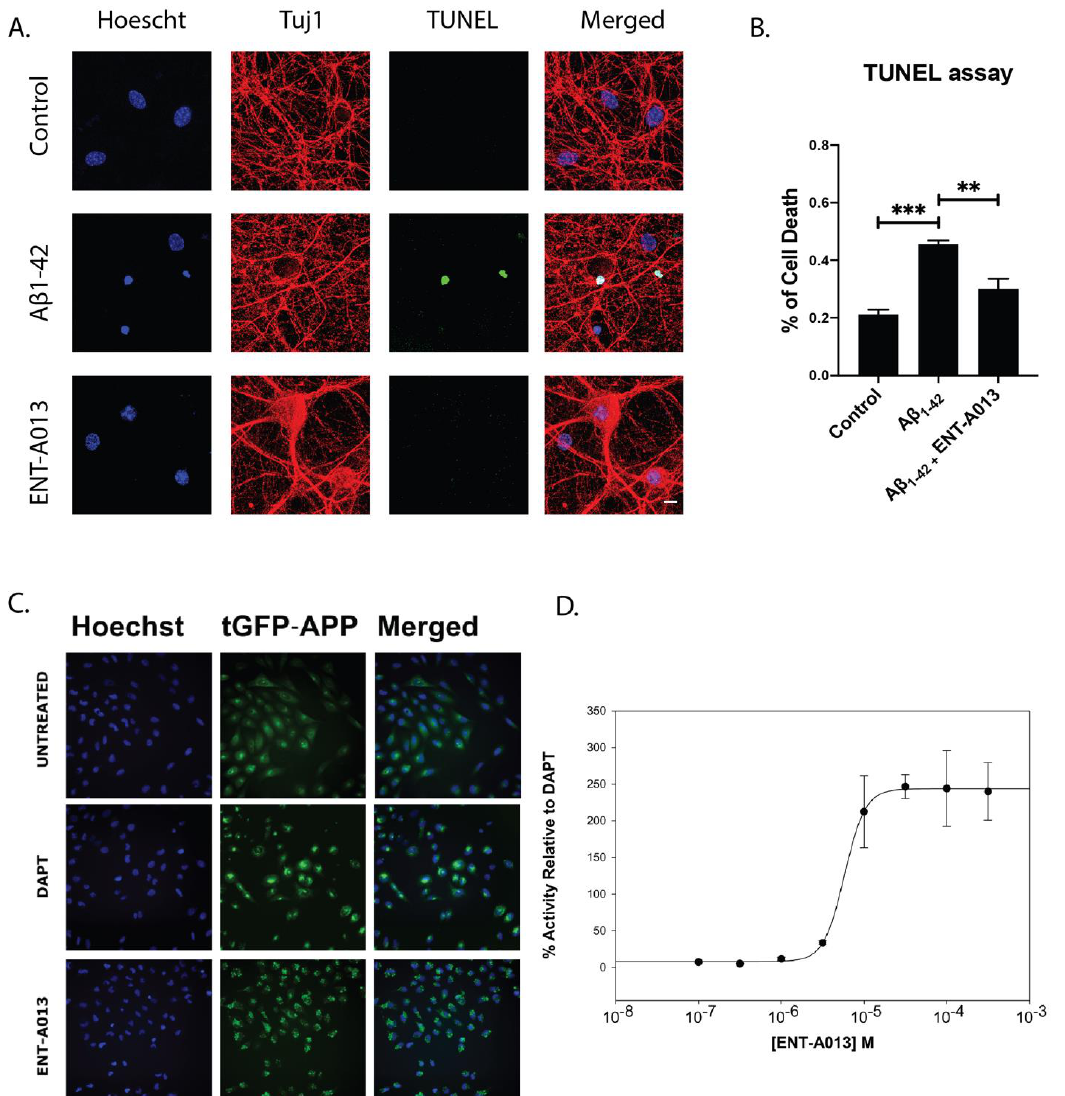
Figure 5. ENT-A013 shows anti-amyloid activity. ( A , B ) Primary hippocampal neurons were treated for 48 h with oligomeric A β in the presence of ENT-A013 and TUNEL assay was used to quantify cell death. Representative images from 3 independent experiments. Data are shown as ±